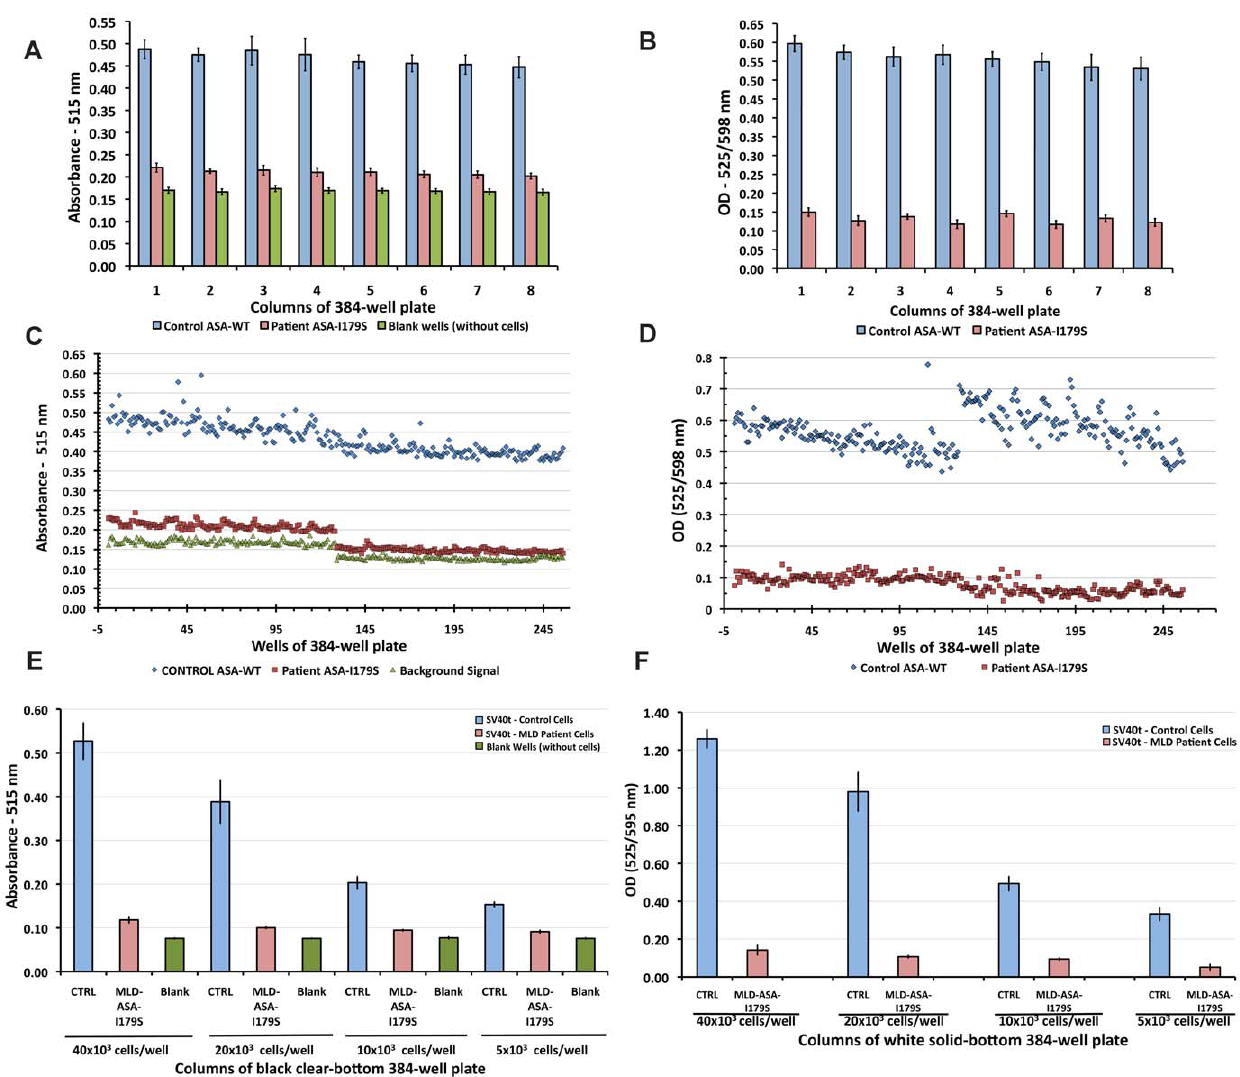
Figure 4. Testing the fluorescence-quench absorbance assay as a throughput assay for ASA activity in cultured cells. ( A ) In cultured SV40t fibroblasts from control (ASA-WT) and MLD patient (ASA-I179S), the absorbance ASA assay (515 nm) was tested and showed robust results in black clear-bottom 384-well plates. Each bar corresponds to the mean signal from 16 wells (one plate column). In 384-well white solid-bottom plates, these cultured SV40t fibroblasts showed comparable results were observed ( B ). Optical density (OD) calculation is described in Methods section. Inter- leaved 384-well plate assays also showed similar results for both ASA absorbance ( C ) and fluorescence-quench absorbance ( D) . In a 384-well plate, SV40t fibroblasts from control and a MLD patient were seeded at different numbers per well ( E ). Using the 15 mM of pNCS substrate concentration in the substrate/lysis buffer, seeding 40 6 10 6 cells/well showed the best results of spectrophotometric assays. By reducing the number of cells in each well, 20 6 10 6 , 10 6 10 6 and 5 6 10 6 , correspondent and equivalent reductions of absorbance signals were observed. ( F ) The same pattern of results was noted when culturing the same number of cells in a white solid-bottom 384-well plate. However, the optical density (O.D.) measurements read at excitation/emission pair of 525/595 nm from white solid-bottom plate showed improvement in the assay-window between ASA enzymatic activity from SV40t control and MLD patient fibroblasts. doi:10.1371/journal.pone.0029504.g004 Table 2. Figure 6 shows the scattered plot result from the plate treated only with DMSO, the plates treated with the lowest (7 6 10 2 3 microM) and highest (114.2 microM) LOPAC concen- trations. The scatter plot results from the remaining five concentrations of LOPAC (0.92, 4.5, 22.8 and 114.2 microM) are shown in Figure S2.